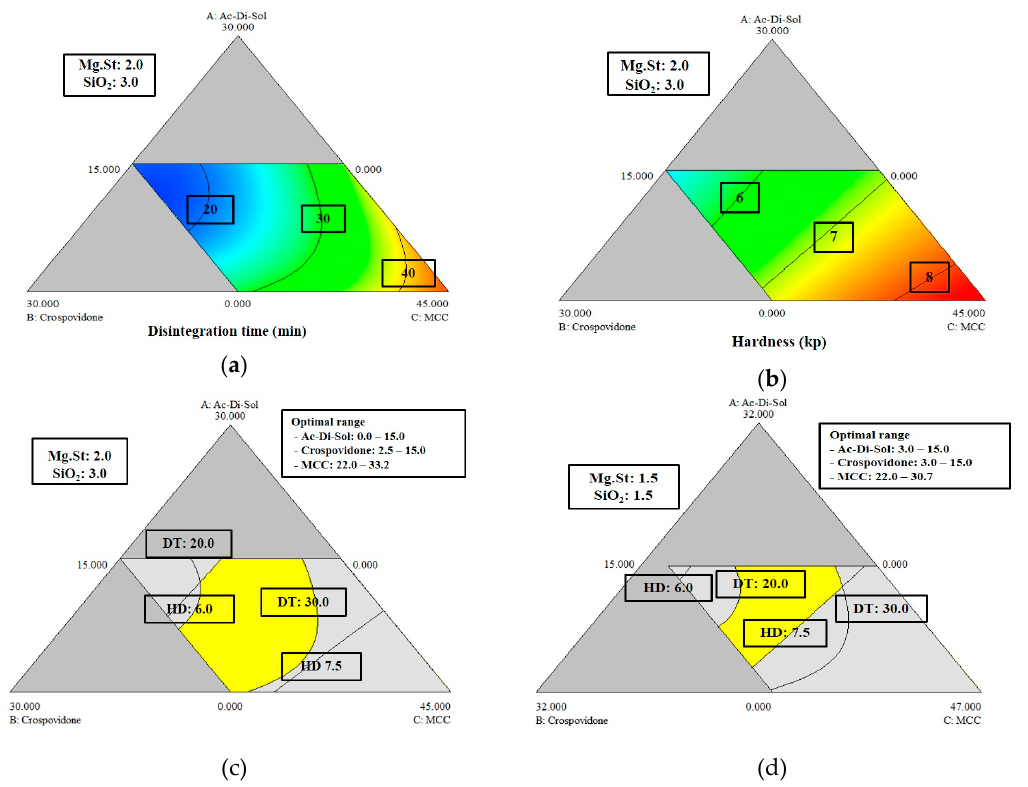
Figure 1. Contour diagrams of the relationships among the formulation variable levels, croscarmellose sodium (CCS, Ac-Di-Sol ® ), crospovidone (Cros), and microcrystalline cellulose (MCC) in fixed levels of magnesium stearate (Mg St, 2.0%) and silicon dioxide (SiO 2 , 3.0%) at the level of 50% of Wuzi Yanzong dry powder extract; ( a ) effects on disintegration time; ( b ) effects on hardness; ( c ) the overlaid diagrams of ( a ) and ( b ) for design space; and ( d ) overlaid diagrams of the effects on disintegration time and hardness in fixed level of magnesium stearate (Mg St, 1.5%) and silicon dioxide (SiO 2 , 1.5%). The yellow areas (design space) show the region where the best responses can be obtained. Figure ( a ) and ( b ) are modified triangular diagrams for three component systems. The number of each apex means the maximum level of each variable. The top corner point in ( a ) represents 30% of CCS (with 15% of MCC and 0% of Cros). The three lines (AB, BC, CA) joining the vertex points represent the combination of A, B, and C; they represent the two component or binary mixtures with the fixed level of the other variable, which is shown in the center on the line. For example, the levels of the variables at the center on line AB are: 15% of CCS, 15% of Cros, and 15% of MCC. The levels of the variables at the center of line BC are 0% of CCS, 15% of Cros, and 30% of